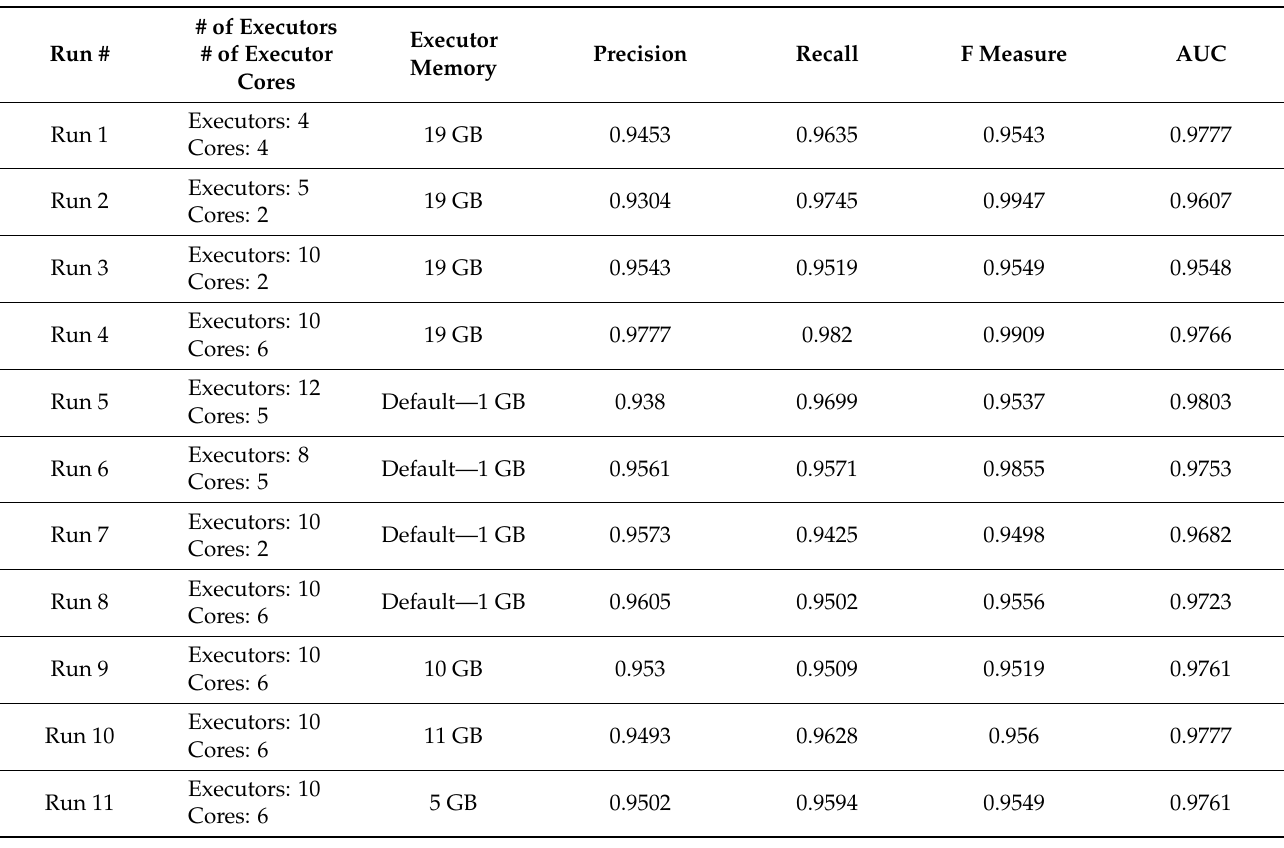
Table 3. Statistical Measures.